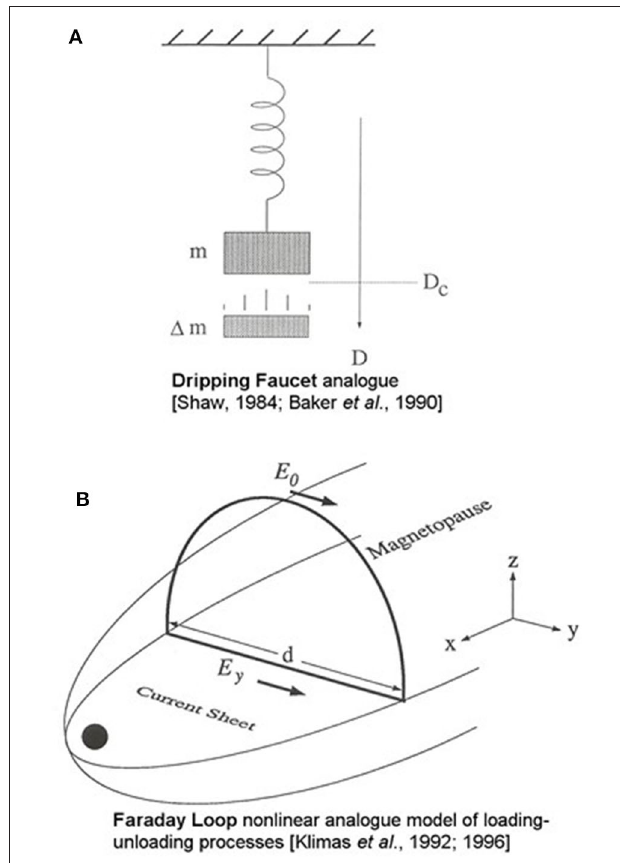
FIGURE 8 | (A) The mechanical analog model for the substorm process: Mass on a spring is increased until a critical distance is reached. At that point, part of the mass is unloaded which causes the mass to move upward, after which the mass loading continues. (B) A Faraday loop model for the magnetospheric activity ( Klimas et al., 1992). The dynamical substorm cycle is represented by a system of changing electric fields and magnetic flux content of the tail lobes. The magnetic flux changes in terms of the electric field imbalance and the magnetic flux content as produced by the tail